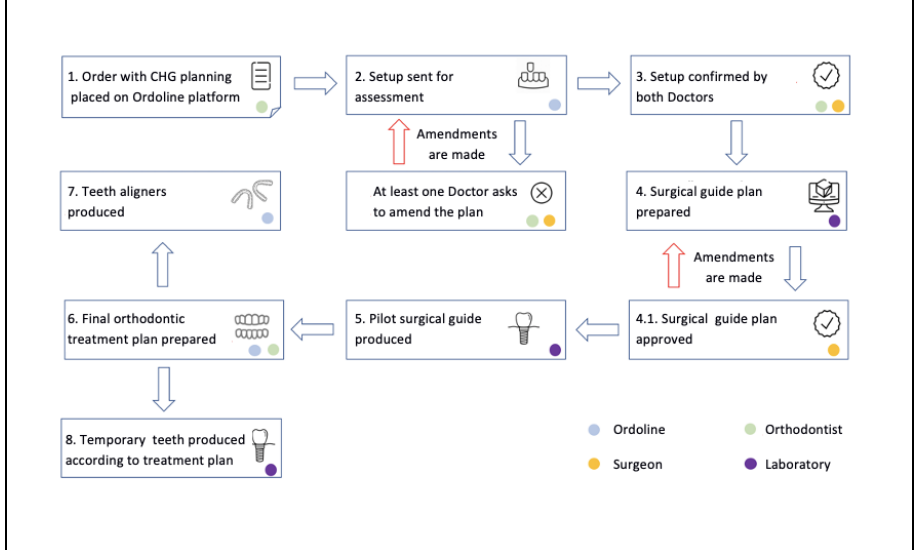
Figure 1. Flow and responsibilities of guided implantation prior to orthodontic treatment.